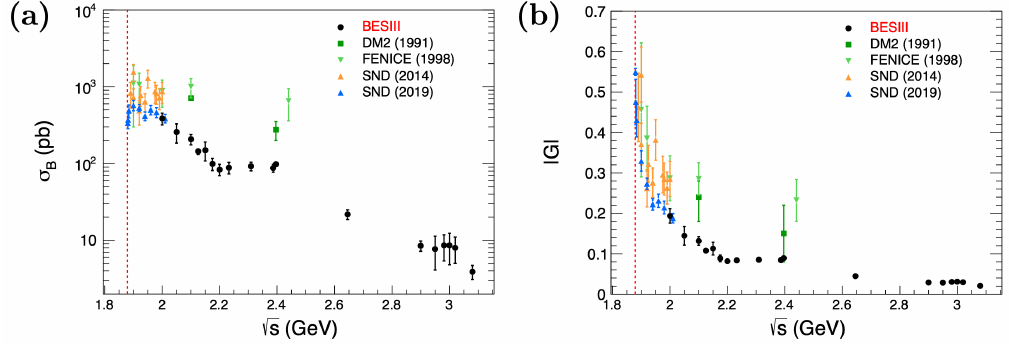
Figure 4: Cross section, panel (a), and effective form factor, panel (b), for the process e + e − → nn [ 9 ]